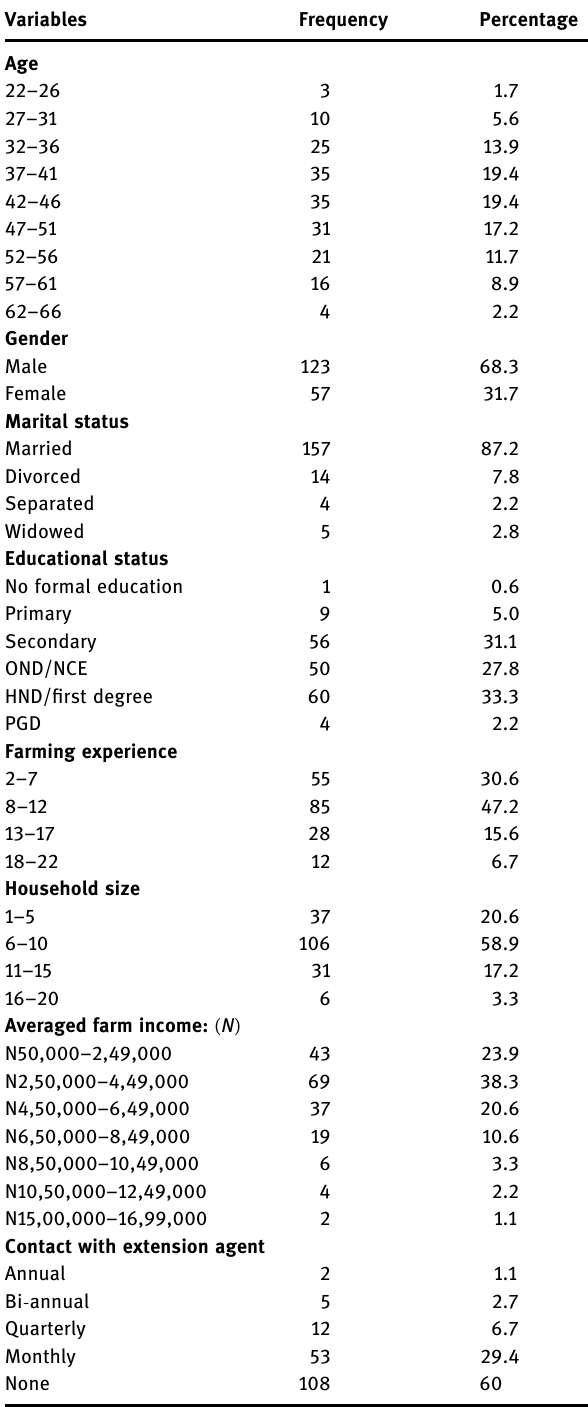
Table 1: Socio - economic characteristics of respondents ( n = 180